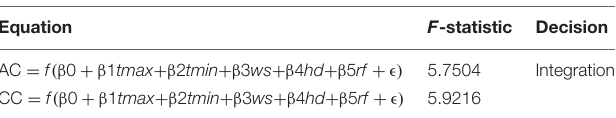
TABLE 3 | ARDL bound